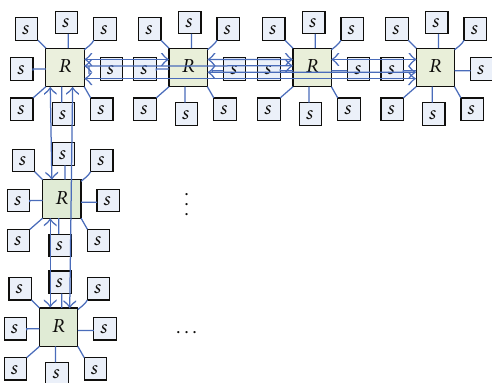
Figure 9: BFC network topology connected to 8 resource nodes.